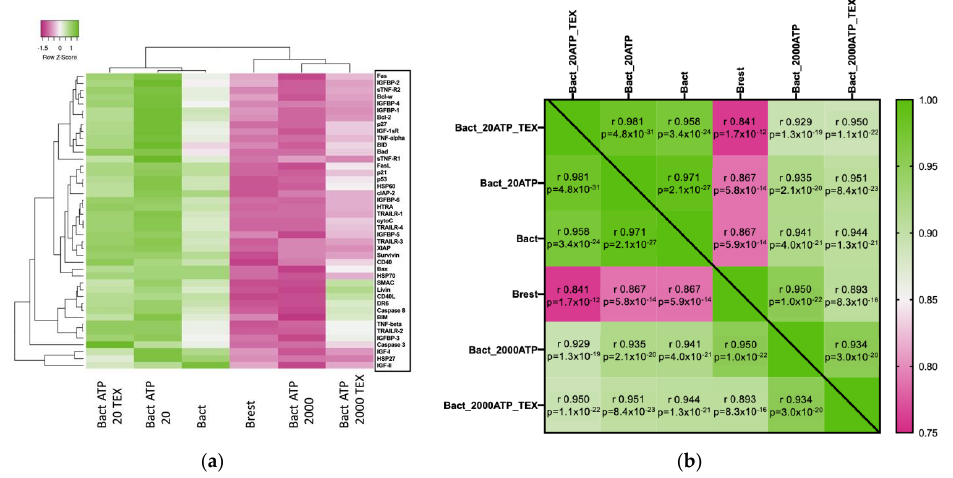
Figure 6. Heatmaps showing the protein expression of 43 different pro- and anti-apoptotic proteins of four independent experiments with isolated B cells in six different conditions (Brest: resting B cells; Bact: activated B cells; Bact with 20 µM or 2000 µM ATP; and Bact with 20 µM or 2000 µM ATP and TEX). ( a ) Unsupervised heatmap with the B cells in the six conditions on the x-axis and the 43 proteins on the y -axis. Unsupervised clustering uncovered two groups: the green-dominated group (Bact and Bact with 20 µM ATP with or without TEX) and the pink-dominated group (Brest and Bact with 2000 µM ATP with or without TEX). Distance measuring method: Pearson. Clustering method: average linkage. ( b ) Heatmap showing the protein expression as an overall mean. Differences between each group were highly significant. The most pronounced differences were between Brest and Bact or Bact + 20 µM ATP +/ − TEX. Pearson correlation matrix with respective r-values (scale 0.75 – 1.00) and statistical significances ( p -values).